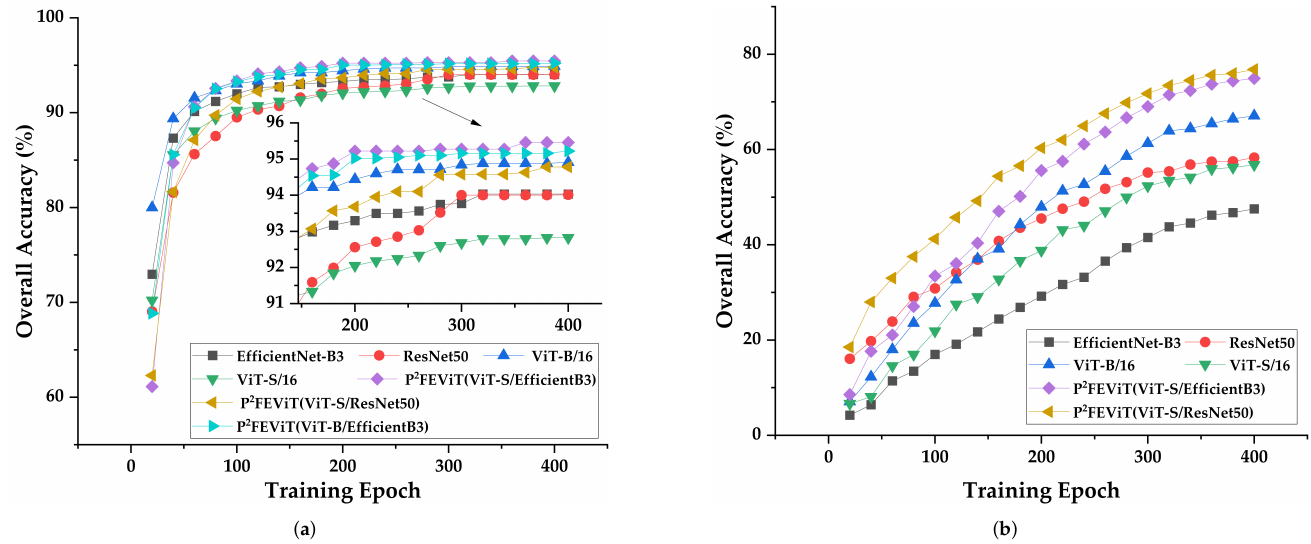
Figure 12. Overall accuracy on BIT-AFGR50 under different initialization conditions. ( a ) fine-tuned with ImageNet pre-trained weights. ( b ) trained from